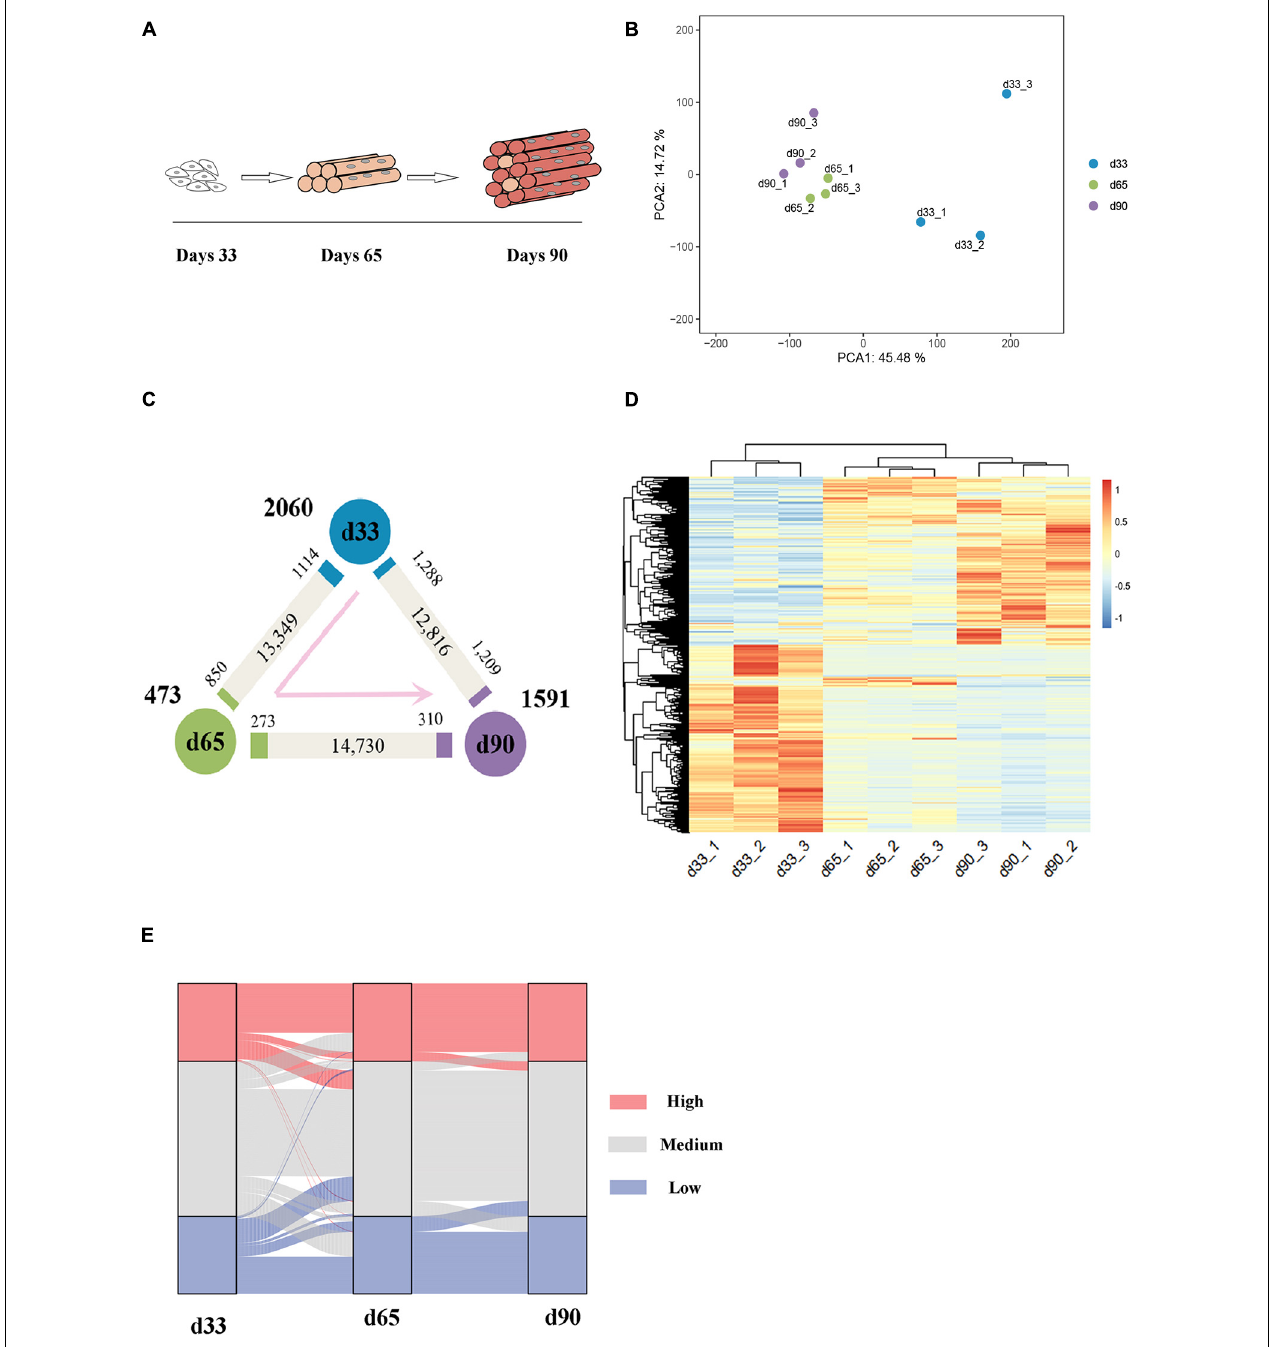
FIGURE 1 | Gene expression dynamics during porcine embryonic muscle development. (A) Scheme for the three key stages in porcine embryonic muscle development. (B) The results of PCA on gene expression data. (C) Gene expression changes. The numbers of gene upregulated ( p .adj ≤ 0.05, ≥ 2-fold change, marked by the corresponding colors) and unchanged (gray) at each stage compared with its neighboring stage are indicated. The numbers of genes expressed at the highest level in each stage are indicated in bold next to each stage. (D) The hierarchical clustering heatmap of DEGs. (E) The alluvial diagram of DEGs. High (TPM ≥ upper quartile); medium (lower quartile < TPM < upper quartile), low (TPM ≤ lower quartile) levels.